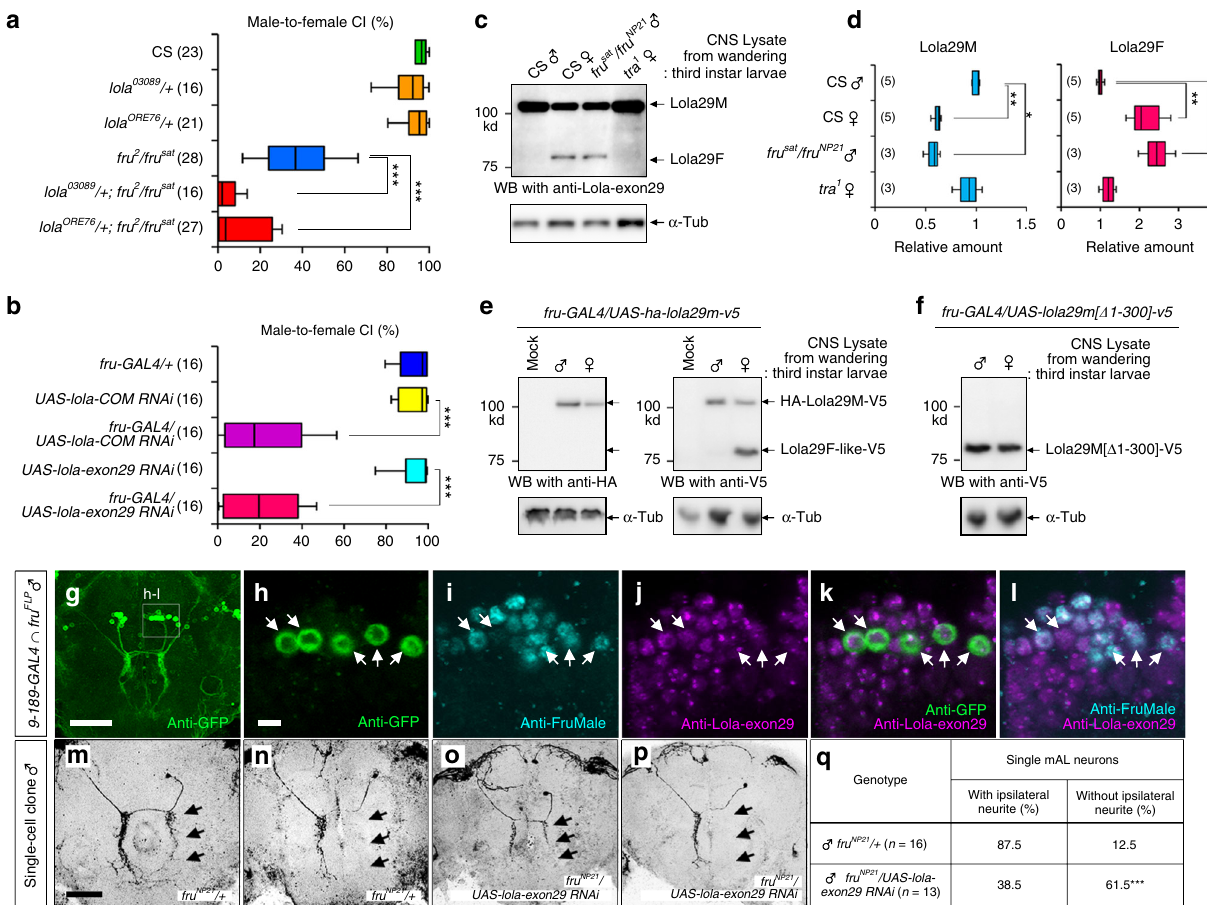
Fig. 1 lola exon 29 contributes to a set of Lola isoforms differentially expressed between females and males. a , b Male courtship activities. Courtship defects in fru hypomorphic males were enhanced in the lola heterozygous background ( a ) and knockdown by lola-COM RNAi (3rd bar from the top) or by lola-exon 29 RNAi (5th bar from the top) suppressed male-to-female courtship ( b ). *** P < 0.001 by the Kruskal – Wallis analysis of variance followed by Steel – Dwass post hoc test ( a , b ). c Western blotting with anti-Lola-exon 29 of CNS extracts obtained from wild-type (CS) males, wild-type females, fru sat /fru NP21 males and tra 1 homozygous females. d Quanti fi cation of Lola29M (left-side panel) and Lola29F (right-side panel), as normalized by the values for the wild-type male. The number of replicates is indicated in parentheses. ** P < 0.01; * P < 0.05 by the Kruskal – Wallis analysis of variance followed by Steel ’ s nonparametric multiple comparisons. The box plot shows the median and 10th, 25th, 75th, and 90th percentiles. e Overexpression of a Lola29M-encoding sequence decorated with a HA-tag at the N-terminus and a V5-tag at the C-terminus (HA-lola29m-V5) yielded the Lola29M protein in males and less abundantly in females, as well as a Lola29F-like protein in females. Shown is a western blot of larval CNS extracts probed with anti-V5 that recognizes